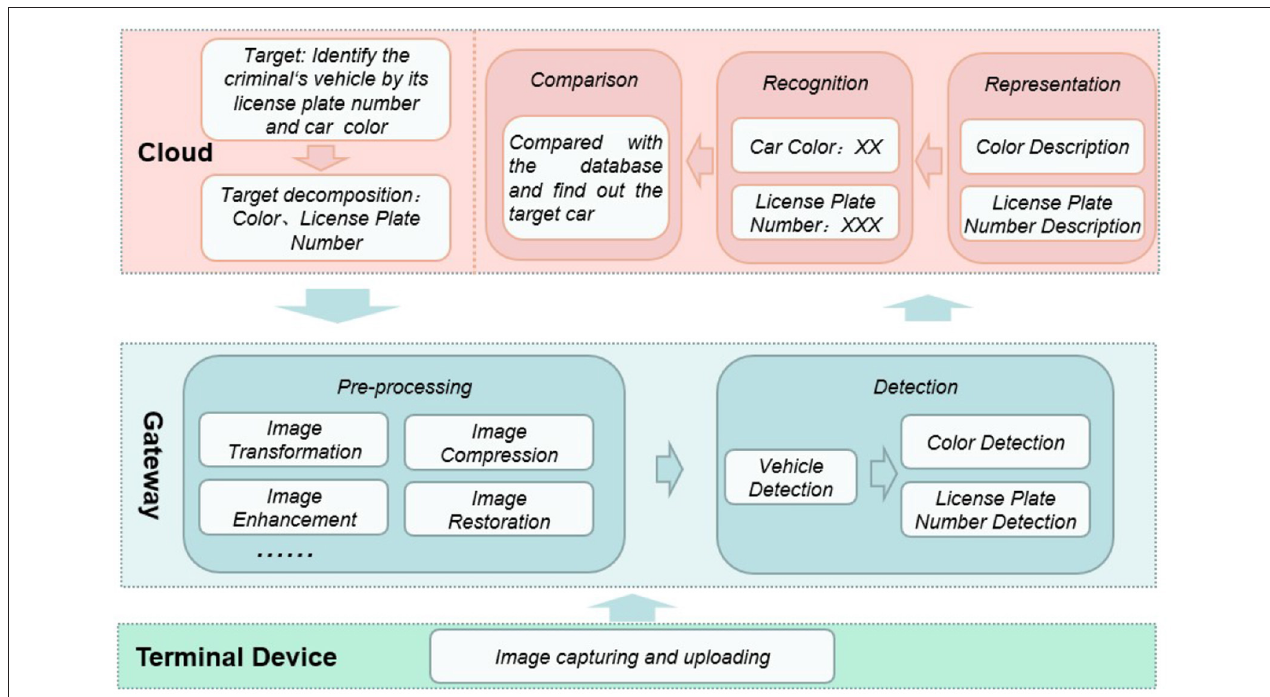
FIGURE 6 | Workflow of Rinegan